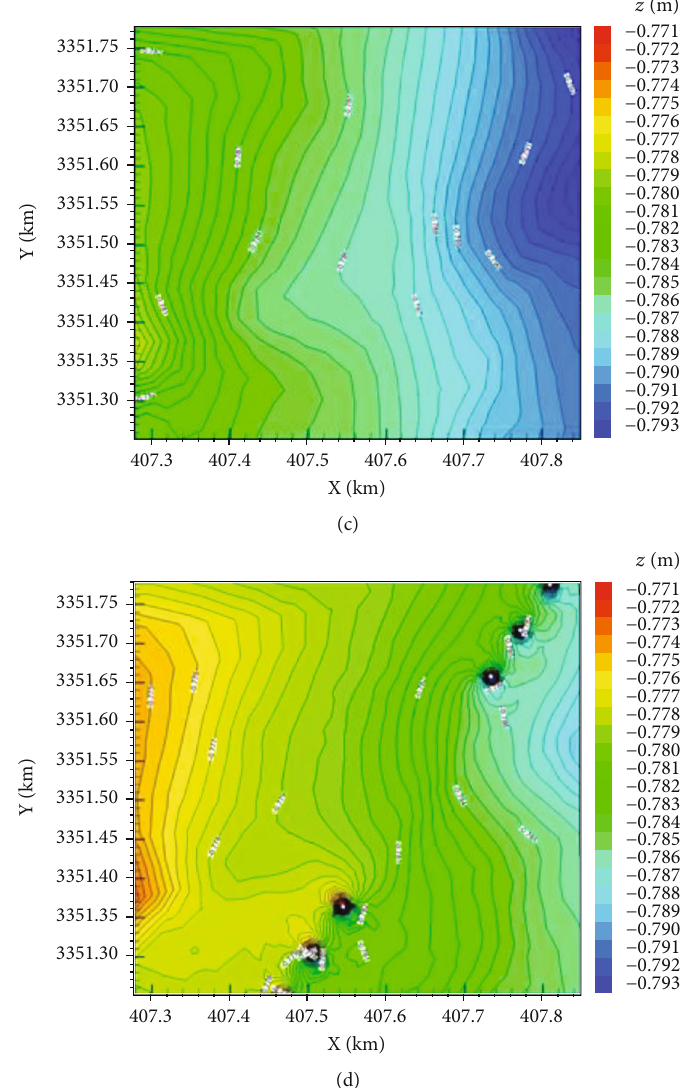
Figure 9: Comparison of tidal level distribution before and after the construction of the project ( z indicates the water level). (a, b) Flood slack of neap tide. (c, d) Flood fall of neap